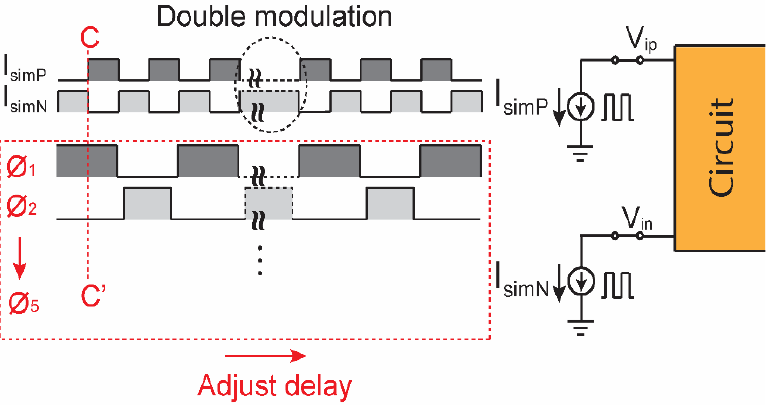
Figure 7. Diagram for the simulation technique to verify the circuit functionality.